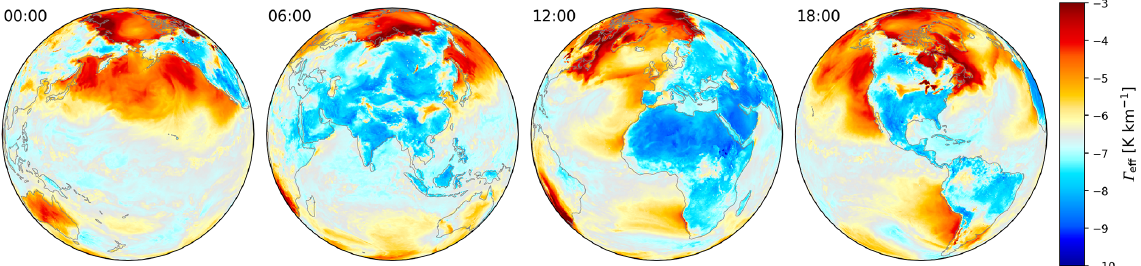
Figure 4. Effective lapse rate (cid:48) eff as defined in Eq. (9) for ERA5 profiles on 18 June